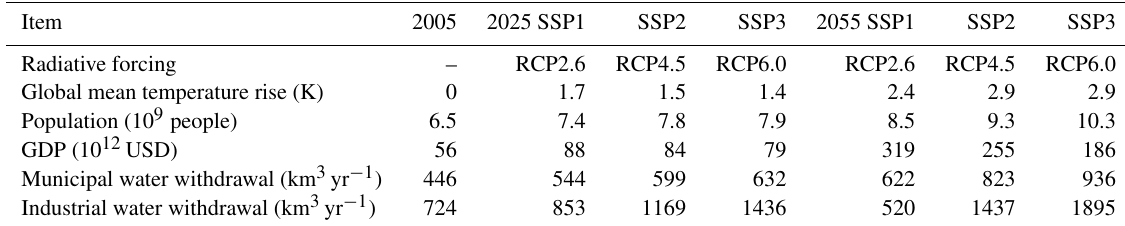
Table 1. Global future scenarios in 2055 (extracted from Hanasaki et al., 2013a, b). Item 2005 2025 SSP1 SSP2 Radiative forcing – RCP2.6 Global mean temperature rise (K)